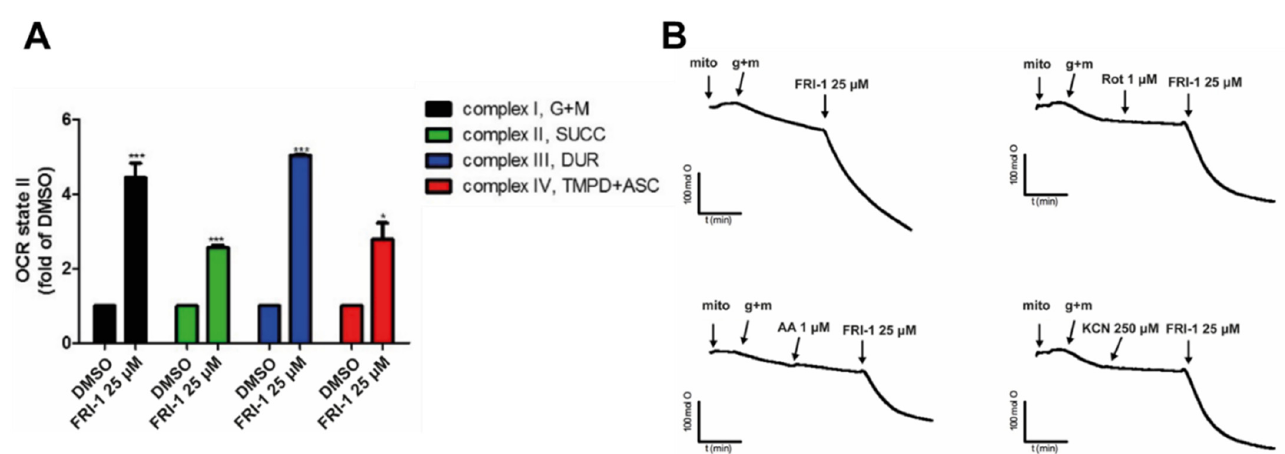
Figure 5. FRI-1 increases mitochondrial oxygen consumption rate in Complex I and III-dependent manners in isolated mito- chondria. ( A , B ) Effect of FRI-1 on OCR in isolated mitochondria from murine BC cells in presence of respiratory substrates or complex inhibitors (Rot, AA and KCN). OCR was determined by Clark electrode. The data shown are the mean ± SD of three independent experiments. * p < 0.05, *** p < 0.001, vs. control (DMSO).